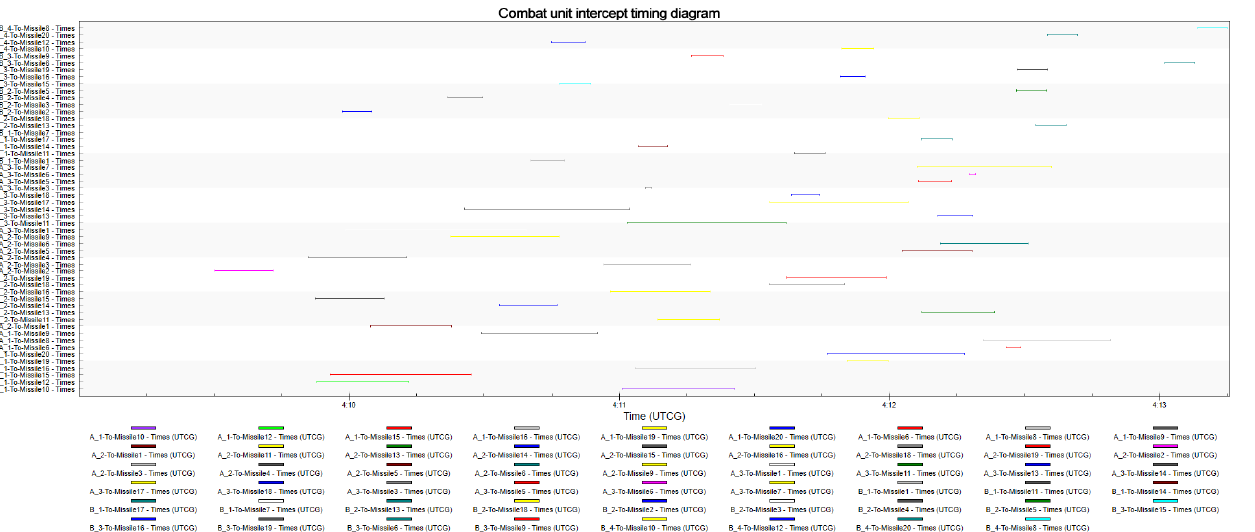
Figure 6. Sequence diagram of incoming target interception.